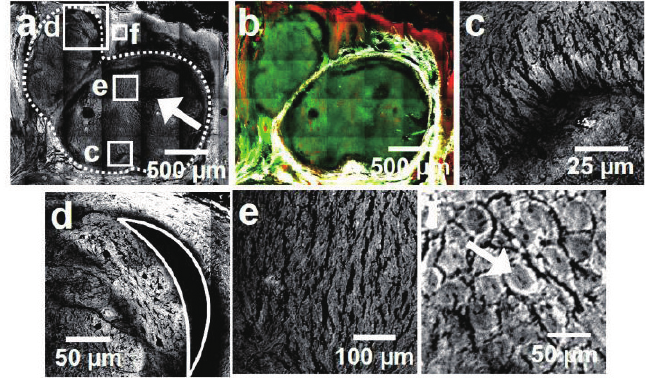
Figure 3. CARS and multimodal image details (CARS: red; TPEF: green; SHG: grays) taken from Figure 2a,d. ( a ) CARS image detail of the BCC tumorous region. The dotted line delineates the tumor nests. The arrow indicates the location of necrotic tissue; ( b ) Multimodal image of the tumorous region. The borders of the BCC tissue are unveiled by the SHG signal. A weak CARS and TPEF signal edging surrounds the tumor facilitating its localization; ( c ) Palisade shaped tumor border — an exclusive feature of BCC. The palisade shaped cells appear slightly brighter than the rest of the tumor nest in CARS; ( d ) Retraction artifact — typically shaped like a half-moon; ( e ) Tumorous tissue; ( f ) Non-tumorous epidermal tissue. Single cells as well as cell nuclei can be